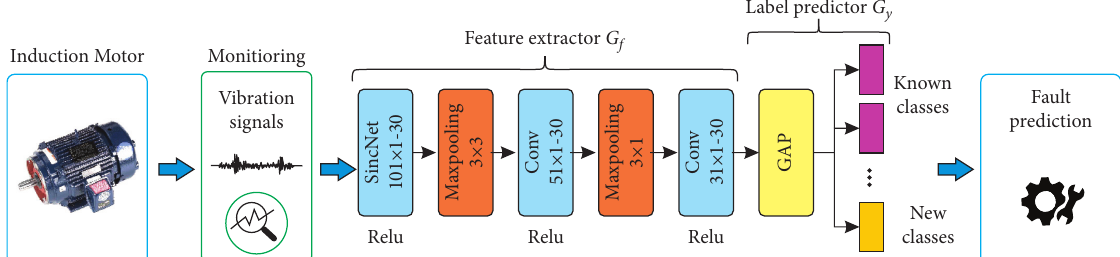
Figure 2: Architecture of the 1D CNN